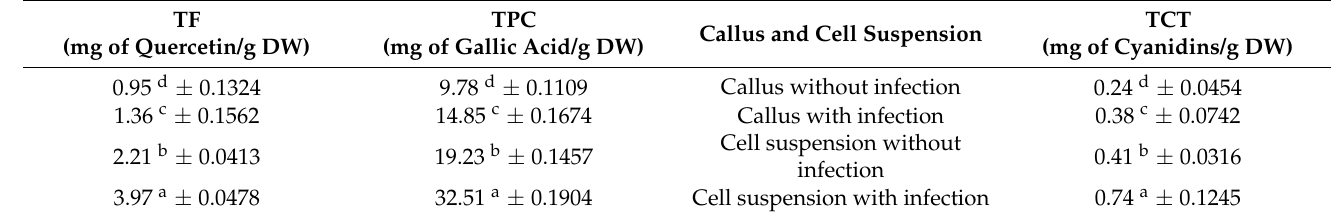
Table 1. Chemical contents of total phenolic, total flavonoid (TF), and condensed tannins (TCT) from cells from methanolic extracts of O. basilicum callus and cell suspensions infected by V. dahliae . TF TPC Callus and Cell Suspension (mg of Quercetin/g DW) (mg of Gallic Acid/g DW)